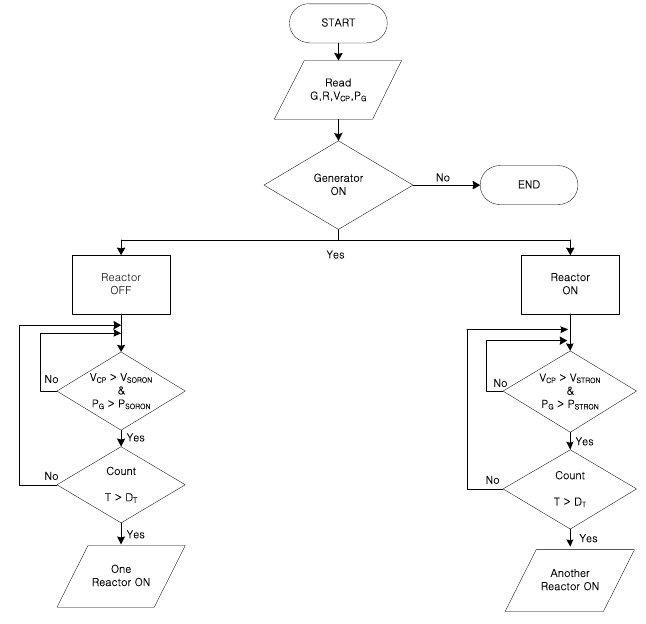
Figure 8. Flow chart for ON operation of reactors.